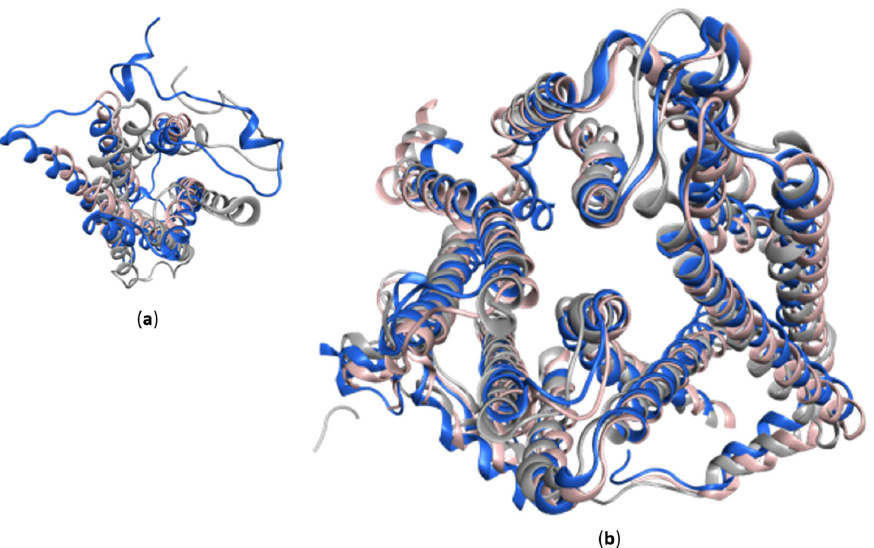
Figure 8. Conformational arrangement of bMRP1 (PDB code: 5UJ9), hMRP1 AlphaFold ‐ 2 model and Ycf1p (PDB code: 7MPE) viewing from extracellular side in MOE. ( a ) Under superposition of the core TMDs, TMD0 of AlphaFold ‐ 2 model and Ycf1p undergoing another conformational derivation. ( b ) Superposition of the TMD1 and TMD2 of three inward facing structures (bMRP1 in pink, AlphaFold ‐ 2 hMRP1 model in blue, Ycf1p in grey).